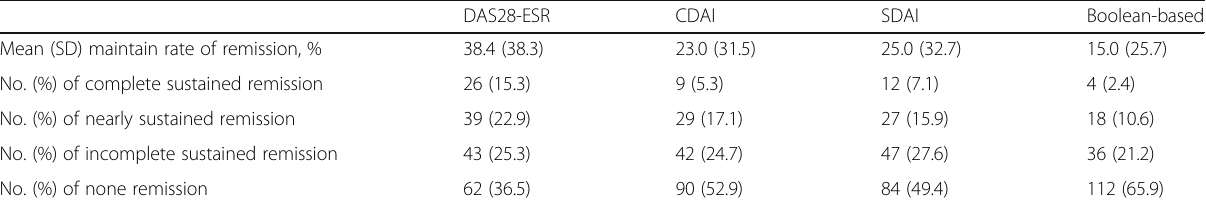
Table 2 Proportions of patients who sustained clinical remission according to each criterion during follow-up